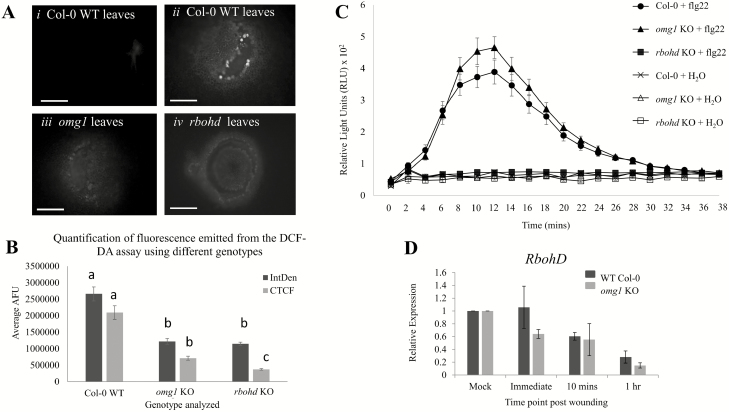
Reactive oxygen species (ROS) accumulation upon wounding and flg22 induction is altered in omg1 leaves compared to Col-0 leaves. (A and B) DCF-DA ROS assay performed on wounded leaf tissues reveals that OMG1 affects cellular ROS production. (A) DCF-DA is a fluorogenic dye that measures hydroxyl, peroxyl and other ROS activity within the cell. A pipette tip was used to wound the surface of the leaves from the WT line, omg1 KO line and rbohd KO line (a known ROS-deficient mutant). Upon wounding, ROS is usually produced around the site of injury. The DCF-DA reagent is then oxidized by ROS resulting in appearance of green fluorescence. Plants were wounded and immediately placed in the DCF-DA solution for 20 min before visualized on the light microscope. (i) WT Col-0 leaves without wounding, (ii) WT Col-0 leaves, (iii) omg1 leaves and (iv) rbohd leaves were placed in DCF-DA solution immediately after wounding. In the WT plants green fluorescence around the wound site indicates the production of ROS. However, in the omg1 KO line and the rbohd KO line, ROS production was not detected. Images were taken on the Olympus BX51 compound scope at 10× magnification, exposure time 55 ms. Scale bars: 100 µm. (B) Quantification of fluorescence was performed using integrated density (IntDen) and corrected total cell fluorescence (CTCF) [CTCF = Integrated density − (Area of selected cell × Mean fluorescence of background readings)] in ImageJ. Statistical analyses were performed using Student’s t-test, bar graphs with different letters show significant difference (P < 0.01). (C and D) Higher elicitor-induced oxidative burst in omg1 KO is not associated with altered expression of RbohD. (C) Extracellular ROS production was measured using a luminol-based assay in leaf discs from omg1 KO, rbohd KO and WT Col-0 plants after elicitation with water or flg22. Experiments were repeated at least three times and results are a mean of 24 samples. (D) The relative expression of RbohD in the WT (Col-0) and omg1 KO leaves was analysed in a wounding assay untouched leaves (mock), immediately after wounding, 10-min post-wounding and 1-h post-wounding. The average relative expression was normalized to a housekeeping gene (UBQ11) and presented relative to the mock controls. No significant difference in RbohD expression between Col-0 and omg1 KO plants was observed when the Student’s t-test analysis was performed. All error bars represent the standard error of the mean of triplicate representative experiments.